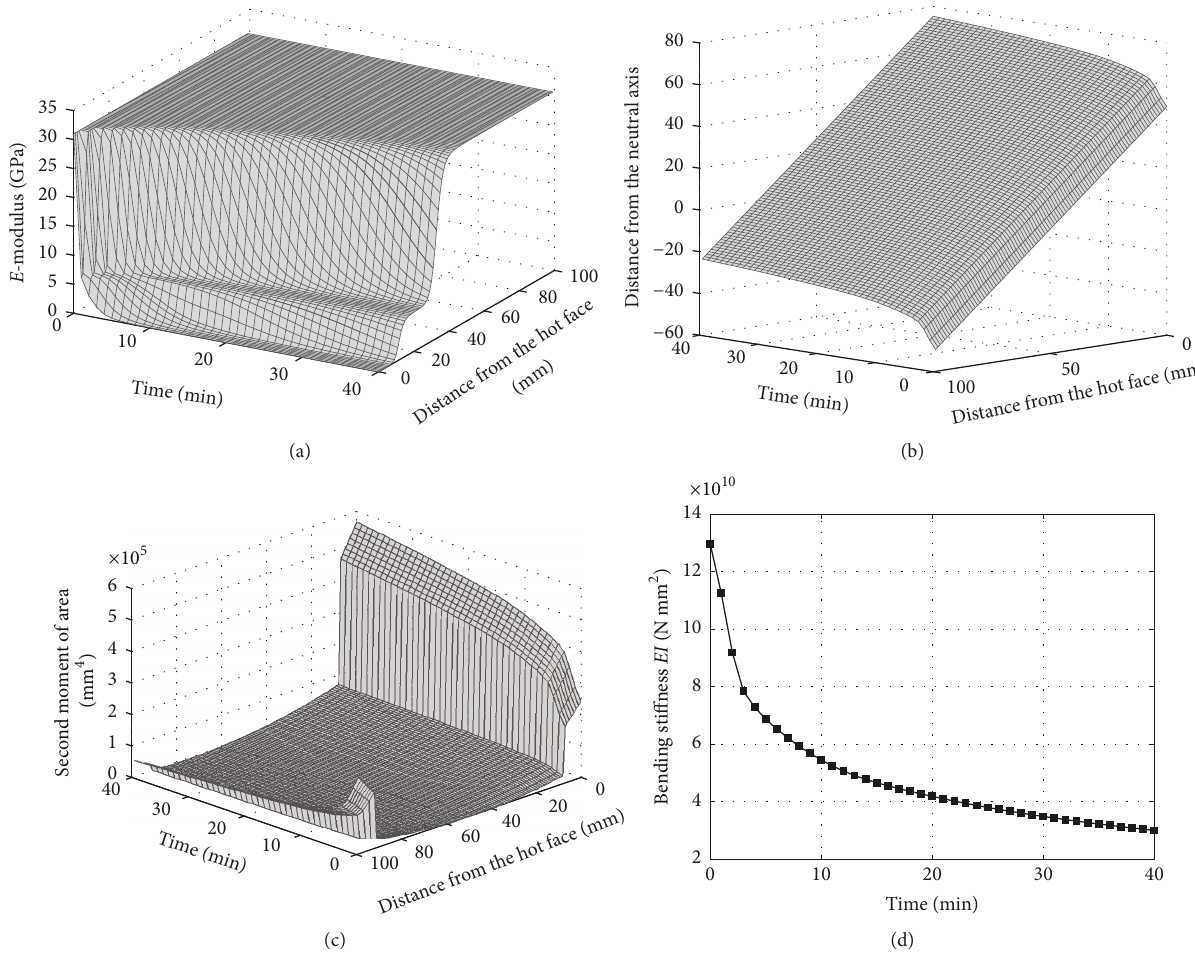
Figure 6: Mechanical responses of GFRP tube: (a) elastic modulus, (b) neutral axis, (c) second moment of area, and (d) bending stiffness.